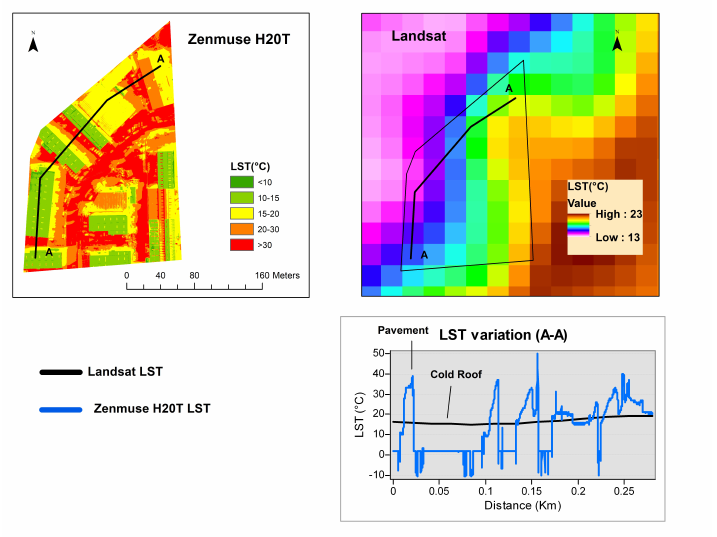
Figure 11. Sectional variation of LST between the Zenmuse H20T and Landsat in IA on 19